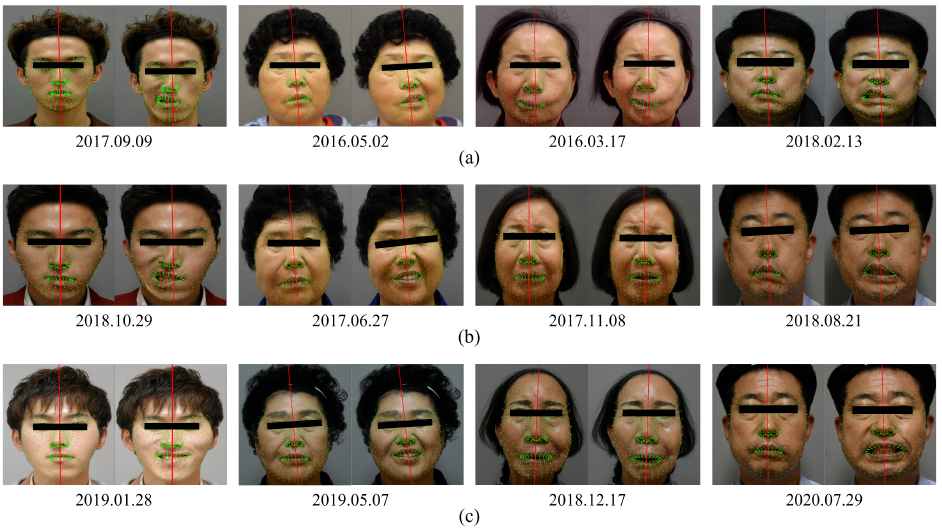
Figure 8. Yearly patient images. ( a ) Year 1. ( b ) Year 2. ( c ) Year 3. The green points present the extracted 3D facial landmarks, and the red horizontal line represents the line connecting the irises. The red vertical line is the midsagittal plane, which is the vertical bisector of the red horizontal line. The images, from left to right, represent Patient 1 to Patient